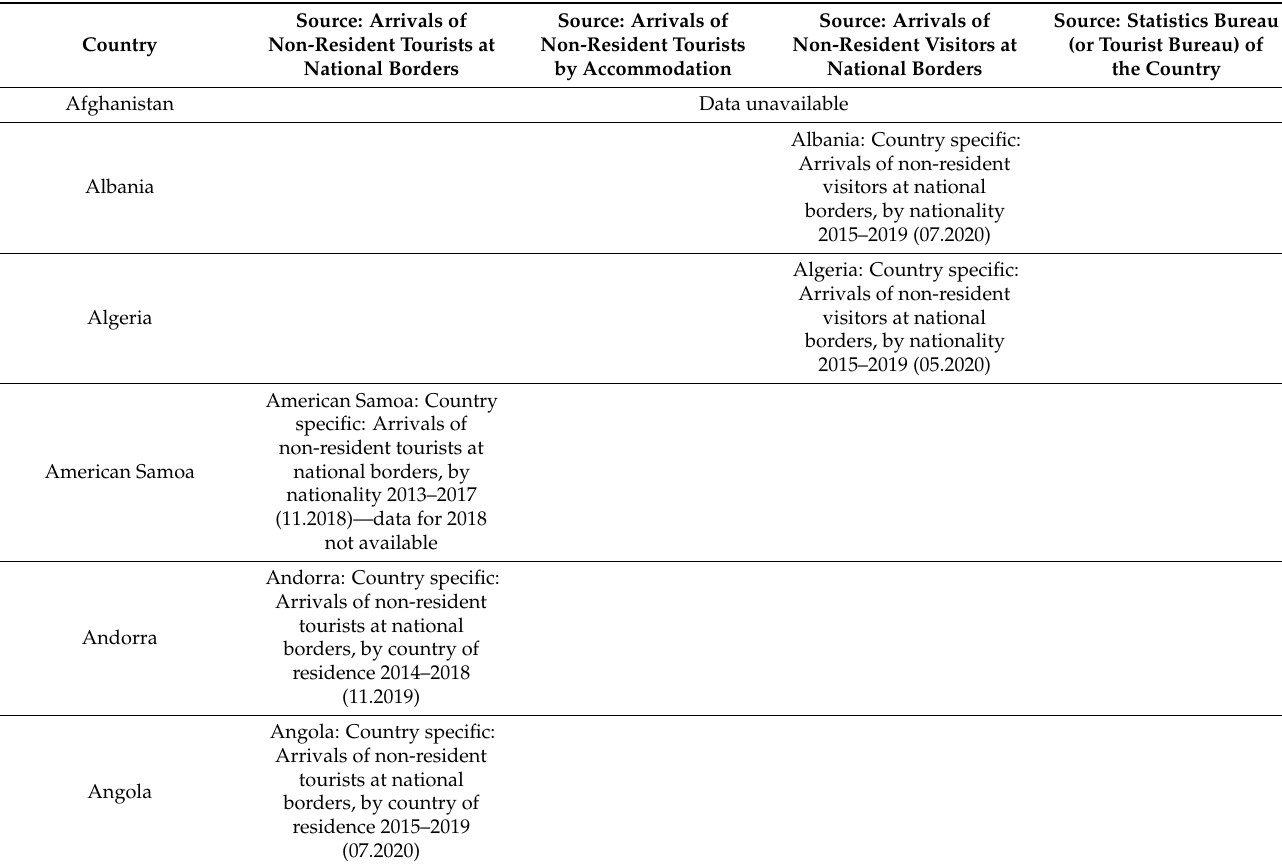
Table A1. Sources of the data on non-resident tourists/visitors by country of